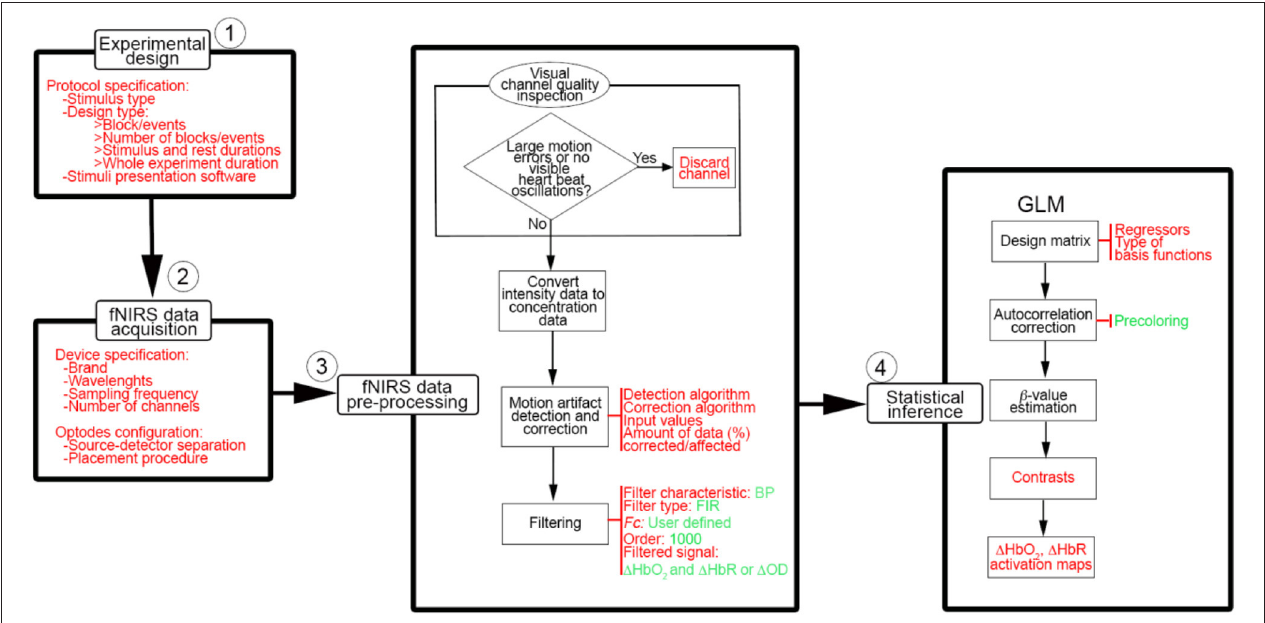
FIGURE 13 | Basic workflow to conduct a typical neuroscience experiment with fNIRS. Information and parameters that we advise to report in research papers are indicated in red and the ones we recommend to use are presented in green.